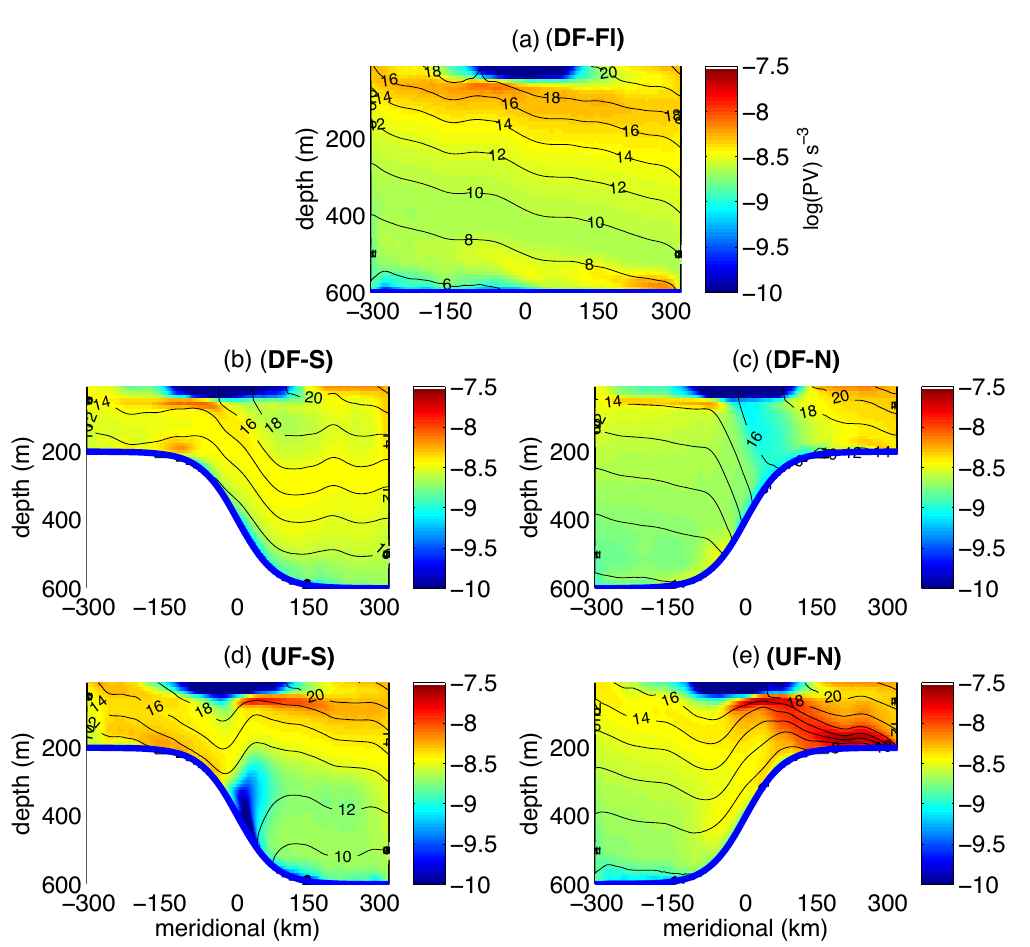
Figure 7. PV cross section in the middle of the domain ( x = 0) averaged from day 800 to 1000. Values are displayed in log 10 scale. Black contours show the mean potential temperature and also indicate isopycnal surfaces. Panels ( a – e ) correspond to experiments (1)–(5) described in Table 1, and experiment ID is